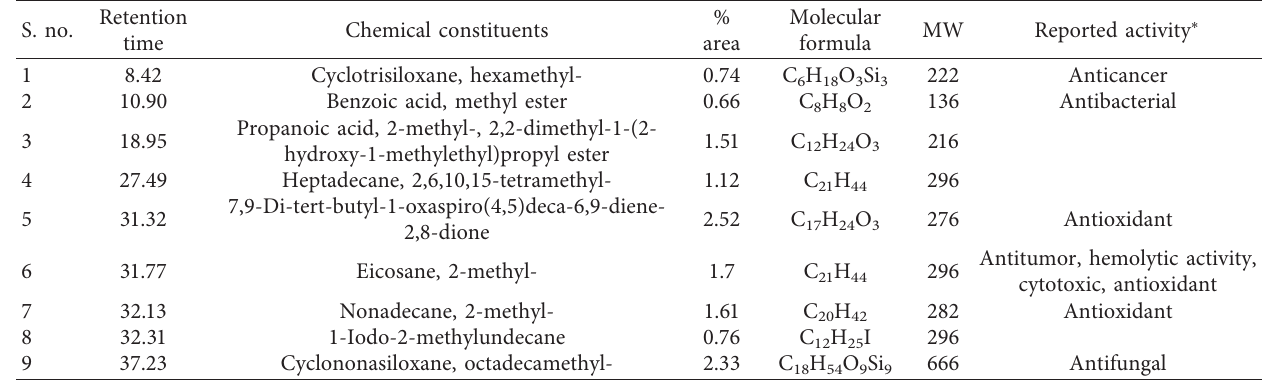
Table 2: GC-MS analysis of petroleum ether extract of S. persica